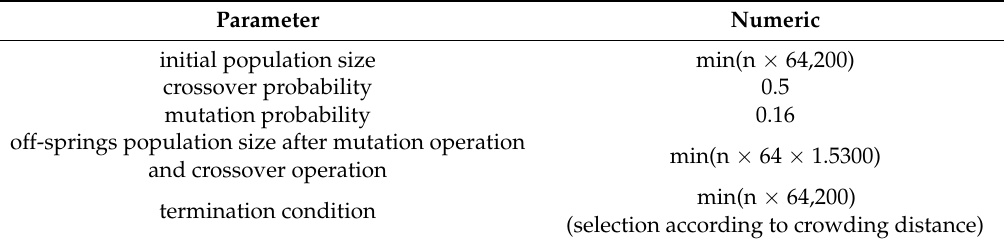
Table 2. Parameter set of genetic algorithm (GA).